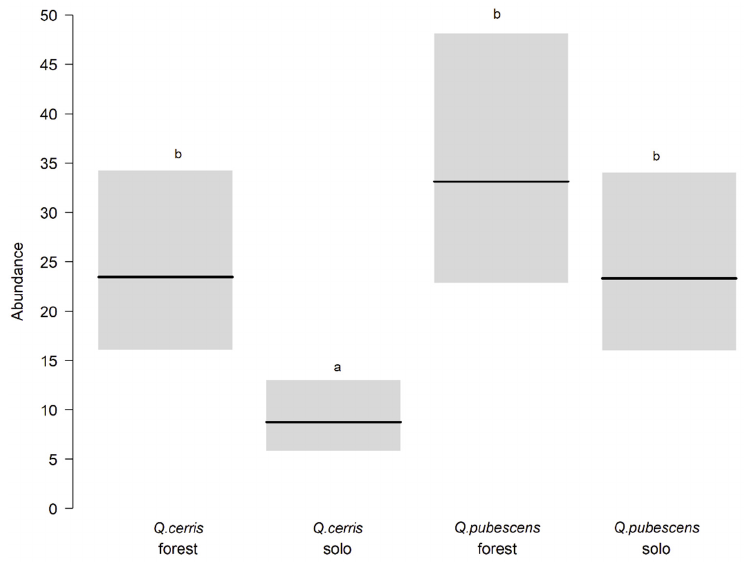
Figure 6. Abundance of caterpillars (number of individuals on two branches, each 1 m long) on young LF Quercus cerris and EF Q. pubescens located in the forest interior and on lone (solo) trees in open forest glades or edges. A horizontal line denotes the mean, and bars the 95% confidence intervals. Distinct letters above columns indicate a significant difference. Species composition (Figure 7). Caterpillar assemblages on LF Q. cerris and EF Q. pubescens did not differ between each other in the forest interior (F = 2.586, p = 0.082) but they significantly did in a non-forest environment, i.e., on lone trees (F = 3.100, p = 0.014). In the case of Q. cerris , assemblages on lone trees were different from those within the forest (F = 3.136, p = 0.014) while for Q. pubescens , they were similar on lone trees and in the forest interior (F = 0.778, p > 0.1).